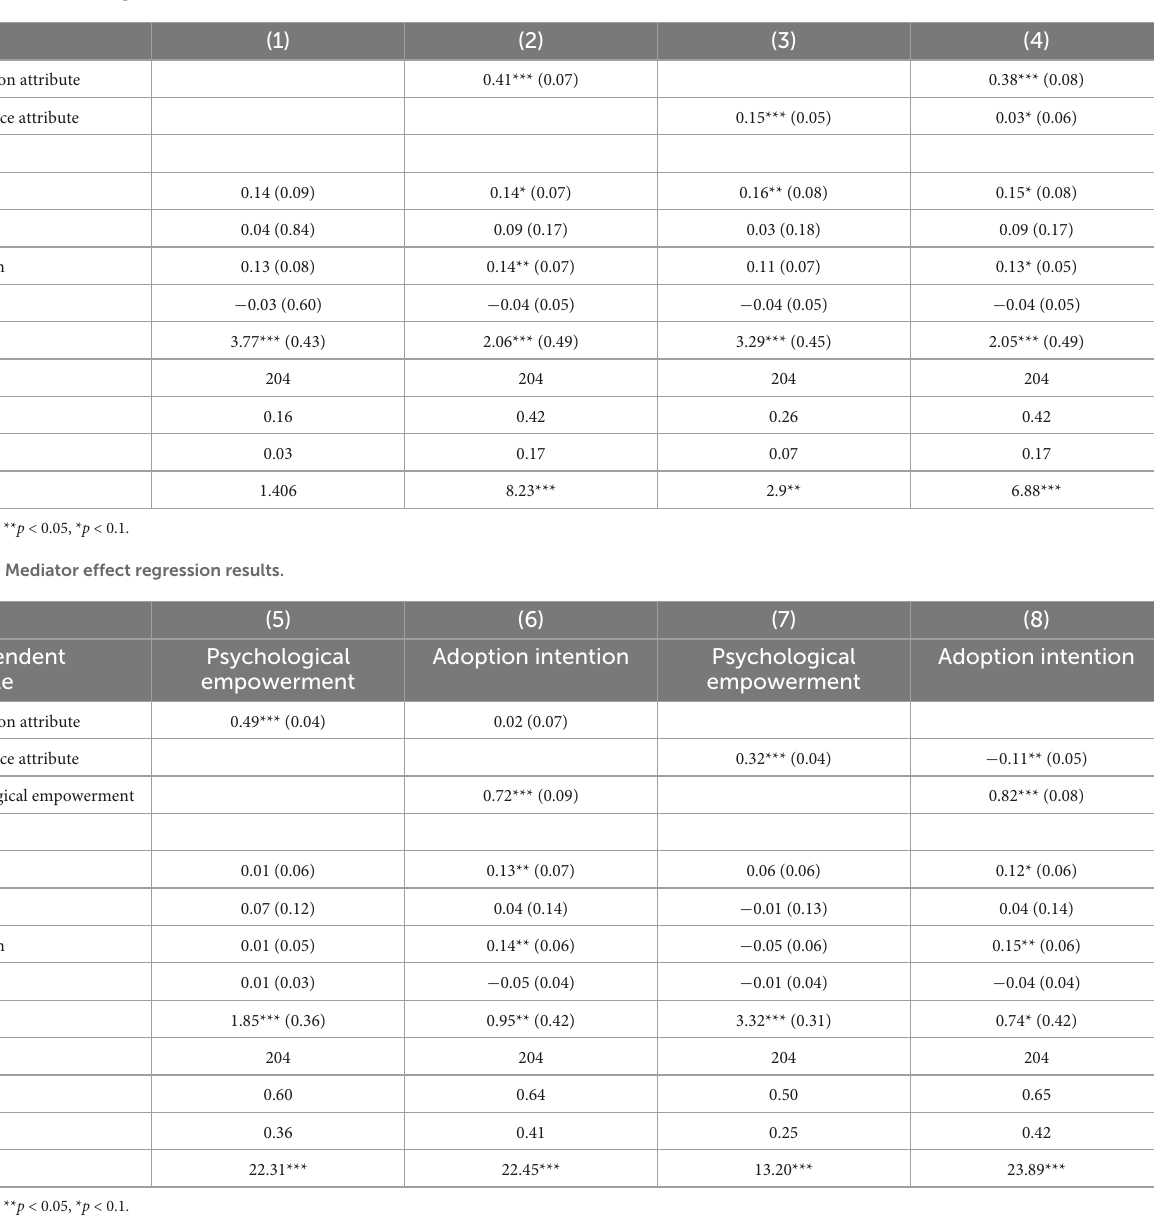
TABLE 3 Main-effect regression results.